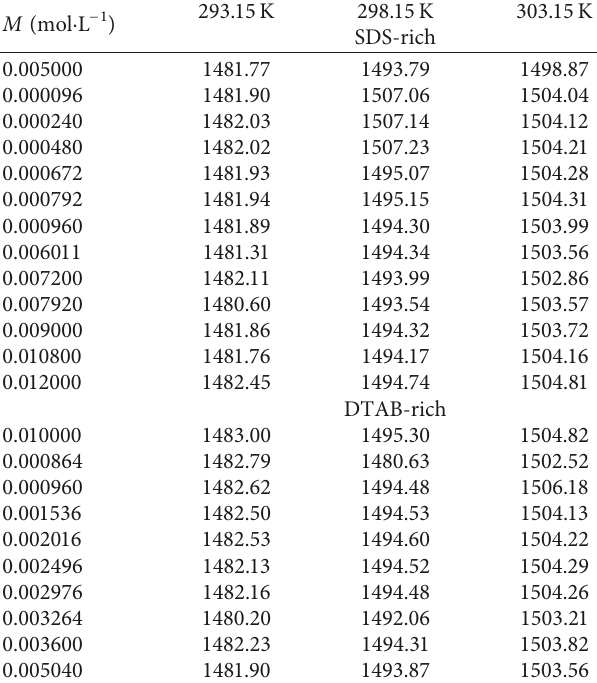
Table 4: Acoustic impedance ( Z /g · cm − 2 · s − 1 ) of SDS-rich and DTAB-rich surfactants in the aqueous medium at the three dif- ferent temperatures T � 293.15, 298.15, and 303.15K and at